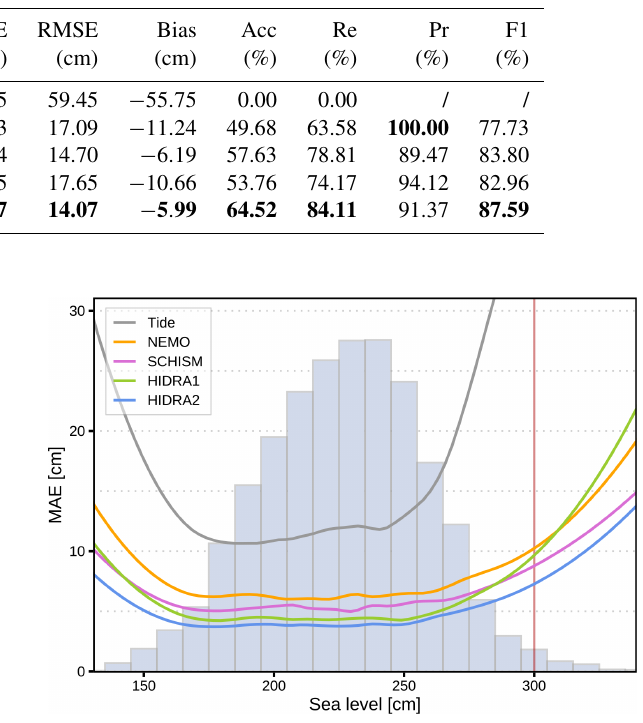
Figure 9. HIDRA, NEMO and SCHISM performances with regard to sea level bins (grey histogram in the bottom layer). The coastal flood threshold is marked with a vertical red line. Performance of all the models was evaluated on a 1 June 2019–31 December 2020 dataset, which is completely independent of the training